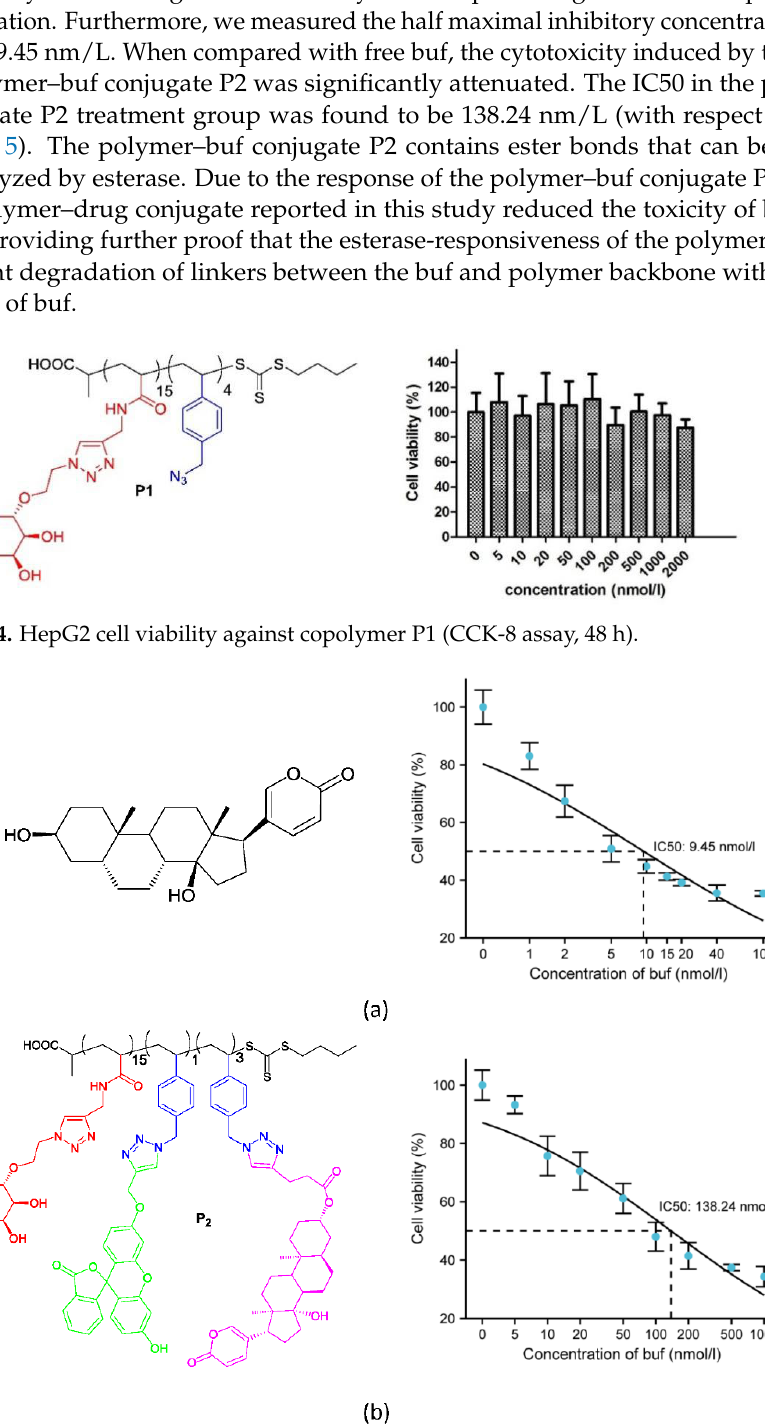
Figure 3. Visualization of cellular uptake of the polymer–bufalin conjugate P2. HepG2 cells were